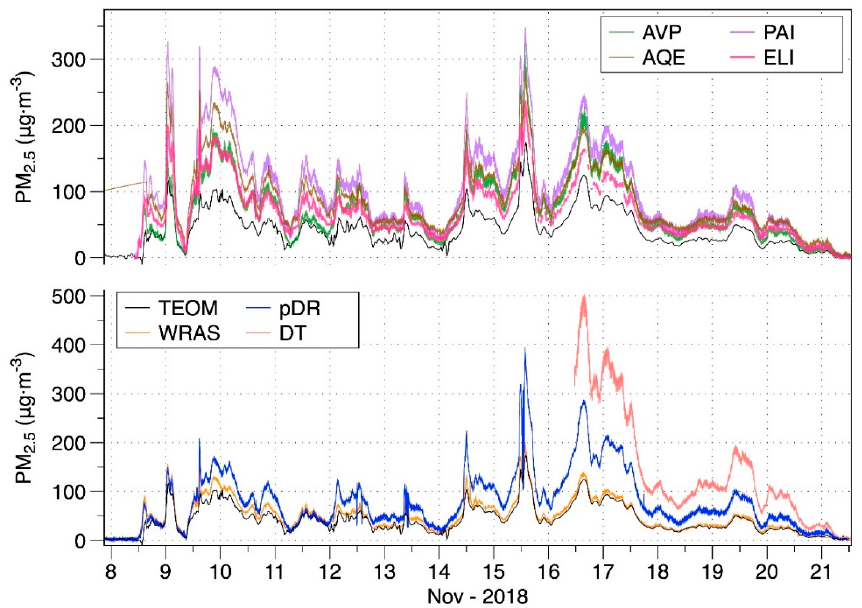
Figure 2. Time series of PM 2.5 as reported by all monitors tested at LBNL. The TEOM is a U.S. Federal Equivalent Method, and thus considered as the reference data. The top group are the monitors utilizing low-cost sensors and the bottom group are professional research grade monitors, with the TEOM reference measurement shown with both groups. Refer to Table 1 for monitor